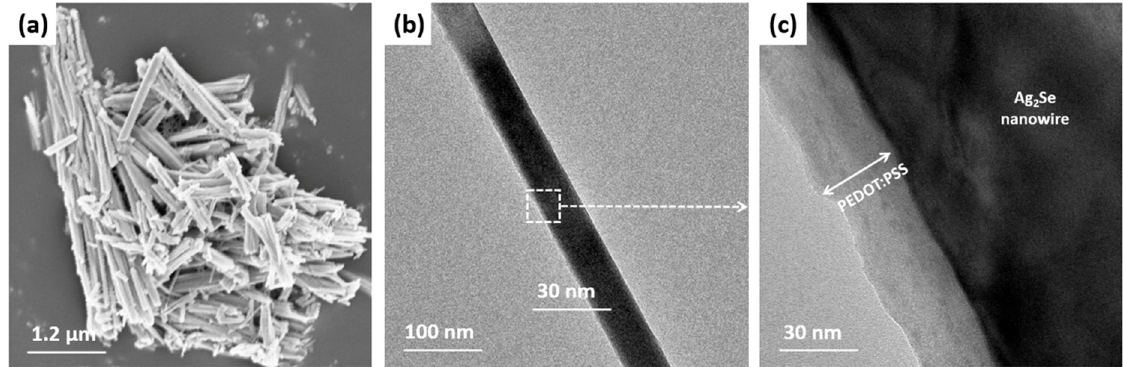
Figure 3. Imaging of the PEDOT:PSS-coated Ag 2 Se NWs: ( a ) FE-SEM; ( b , c ) low- and high-magnification FE-TEM.